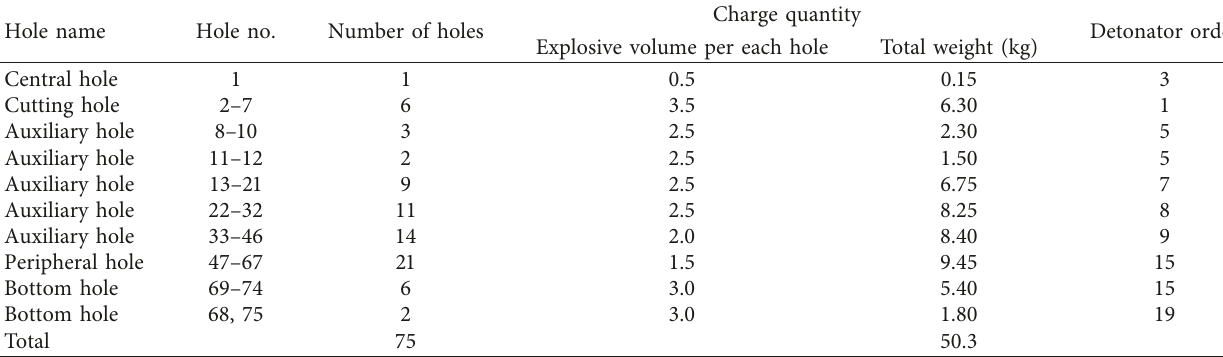
Table 2: Blasting parameters of single-wedge hole cutting.